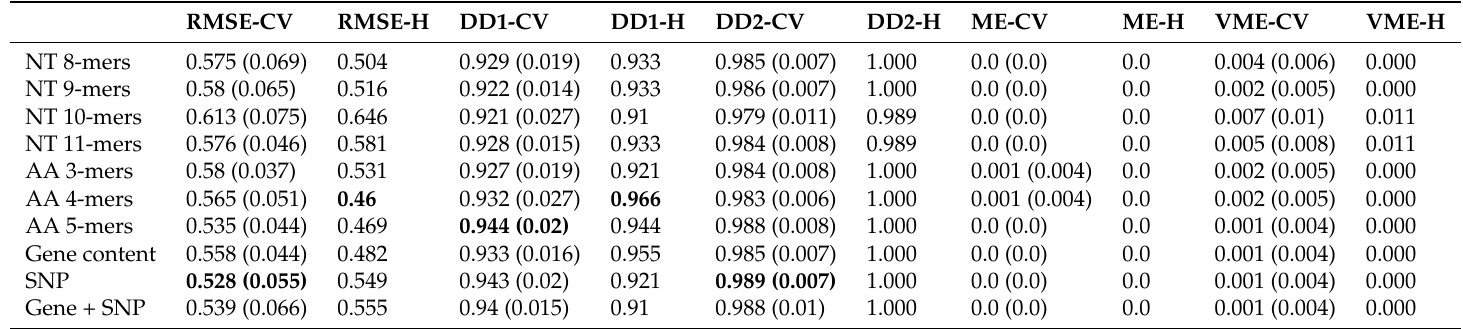
Table A38. K. pneumoniae